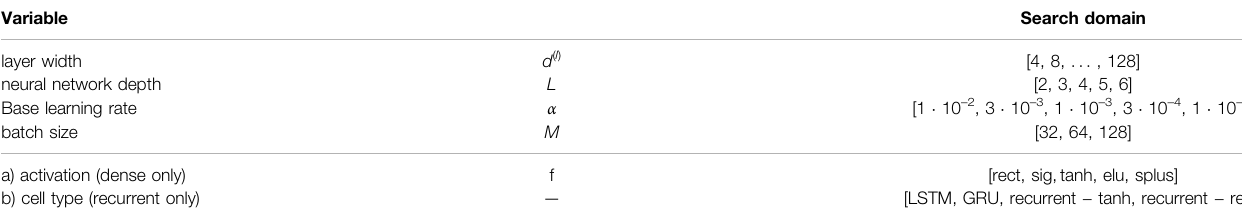
TABLE 1 | Hyperband search domain for constitutive models. Variable Search